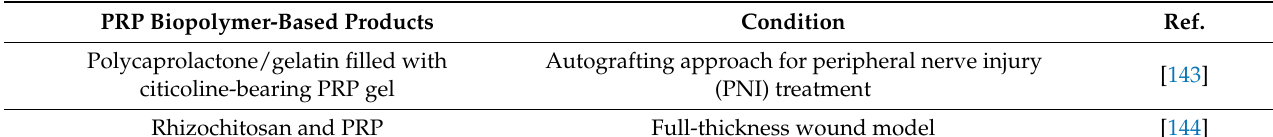
Table 3. PRP biopolymer-based